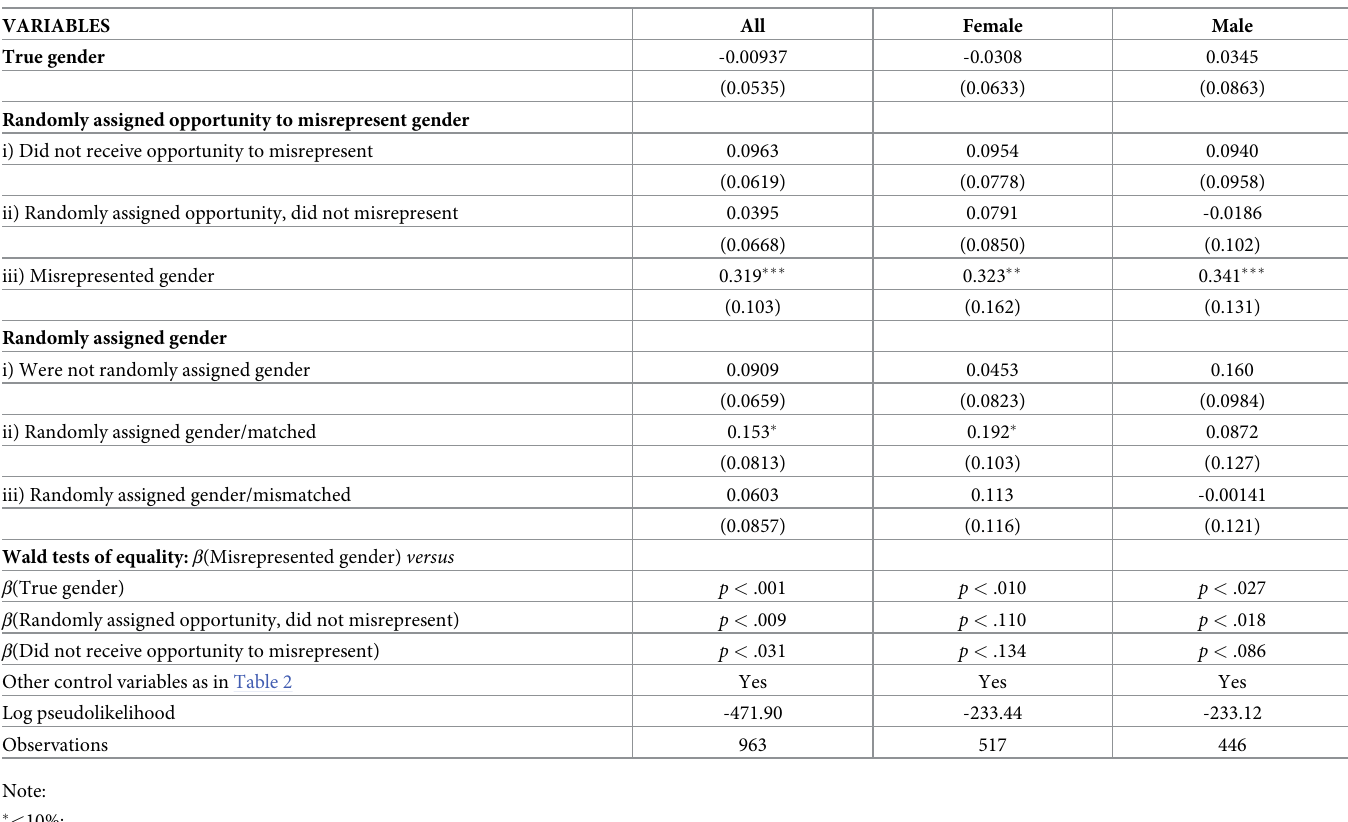
Table 4. Unpacking the treatment effects on the decision to steal: Marginal effects probit